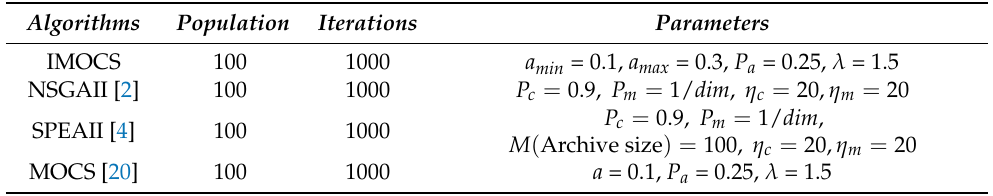
Table 2. Parameters setting of examined algorithm.